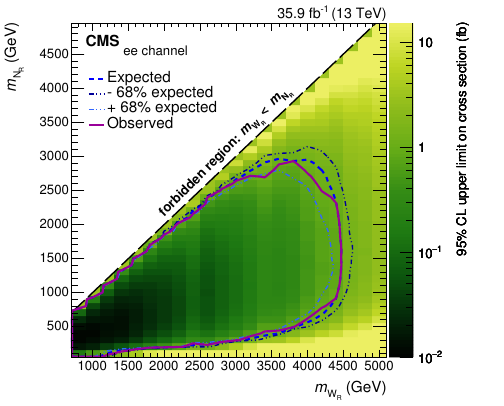
, m N ) parameter space that is expected to be R R boson R = 1 = 2 m is excluded N R W R